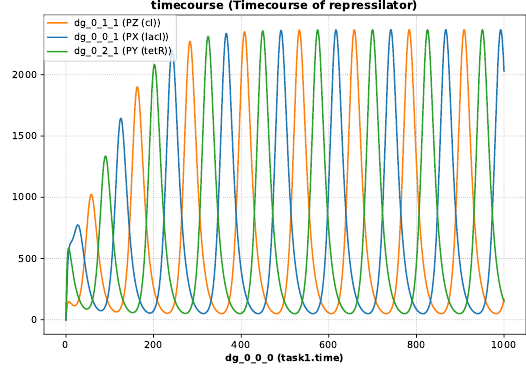
Figure 1.2: Time-course simulation of the repressilator depicting repressor pro- teins lacI, tetR and cI. Simulation with tellurium